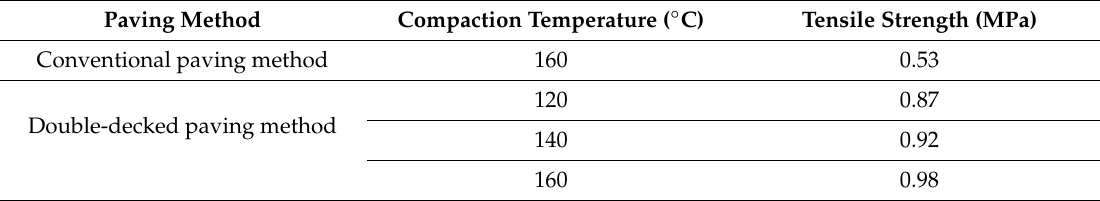
Table 5. Tensile strength of specimens prepared by conventional and double-decked paving methods.